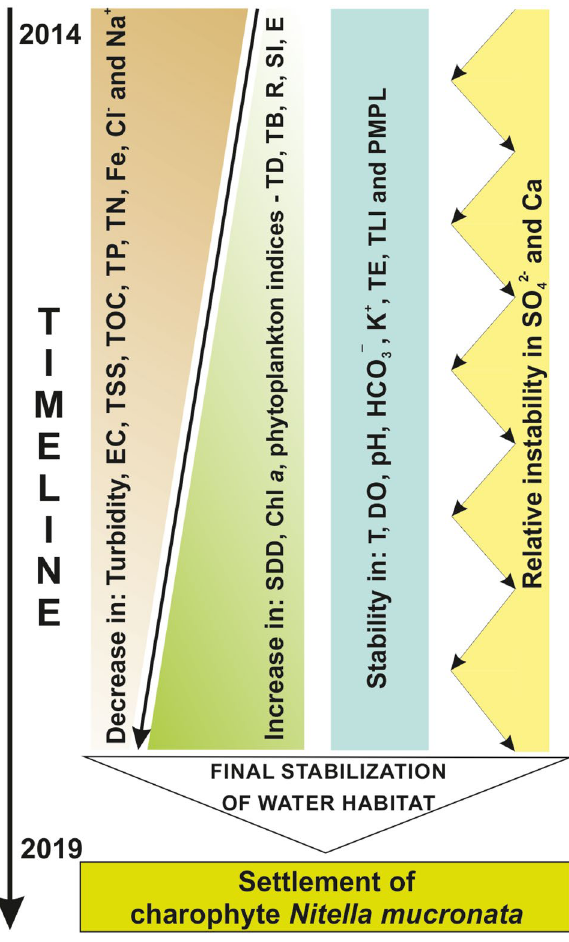
Figure 4. Sequential ecosystem changes and settlement potential in clarification pond. EC electrical conductivity, TSS total suspended solids, TOC total organic carbon, TP and TN total phosphorus and nitrogen, Fe total iron, SDD Secchi disk depth, Chl a chlorophyll a content, TD and TB total density and biomass, R richness, SI Shannon index, E evenness, T temperature, DO dissolved oxygen, TE trace elements, TLI trophic level index, PMPL Phytoplankton Metric for Polish